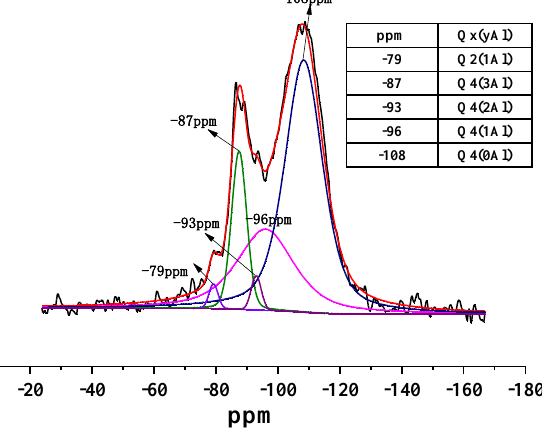
Figure 4. 29 Si MAS NMR spectra of HAFA.